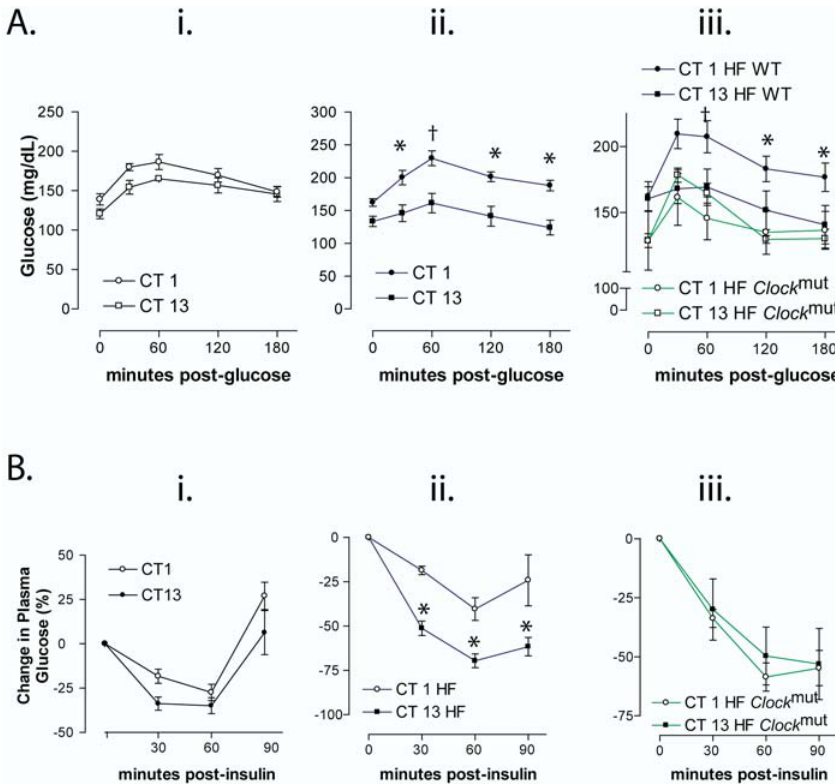
Figure 4. The Molecular Clock Conditions HF-Induced Circadian Variation in Glucose Homeostasis (A) Glucose tolerance (GT) in RC-fed WT mice (i), HF-fed WT mice (ii), and HF-fed Clock mut mice (iii). (B) IT in RC-fed WT mice (i), HF-fed WT